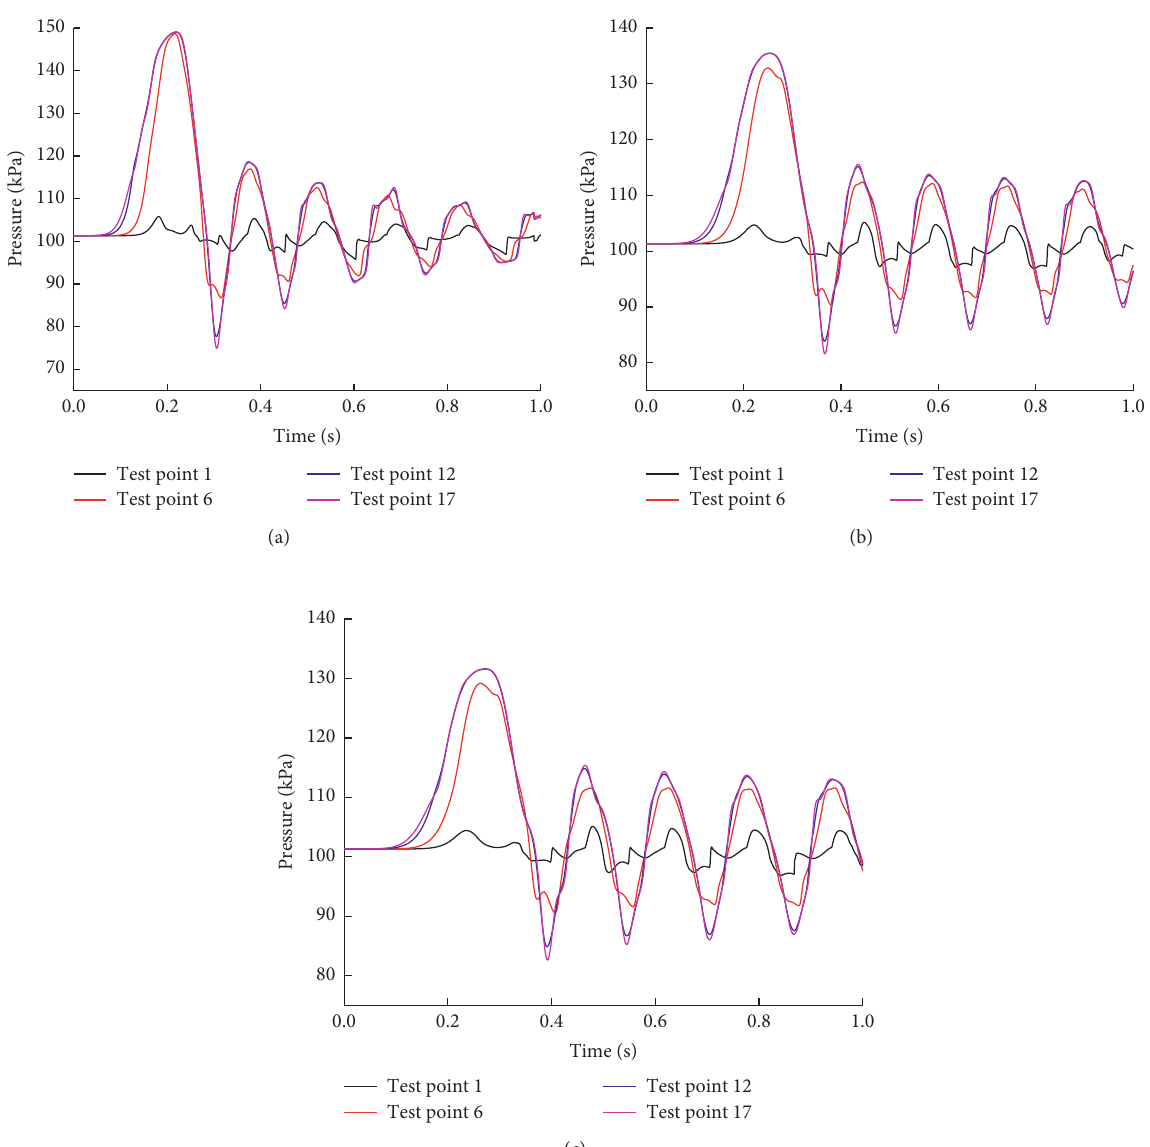
Figure 17: Curves of pressure vs. time under different gas concentrations: (a) 2% C